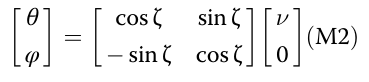
Pinhole source measurement To simulate fl uorescent point sources, a random dis- tribution of 8 pinholes of 25um diameter are etched into a 100 nm chrome layer on a 1 inch fused silica wafer. For both ATTO 465 and ATTO 490LS separately, we